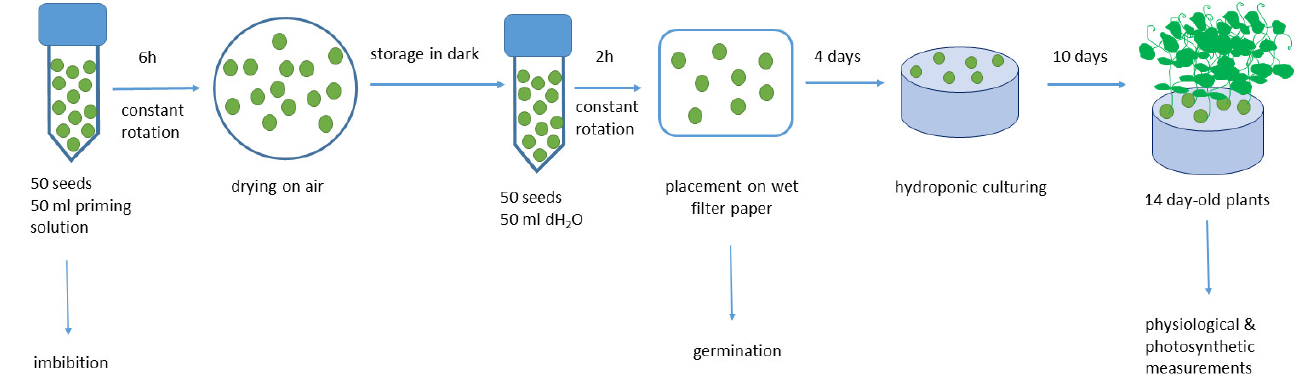
Scheme 1. Experimental design. For further details see text in Section